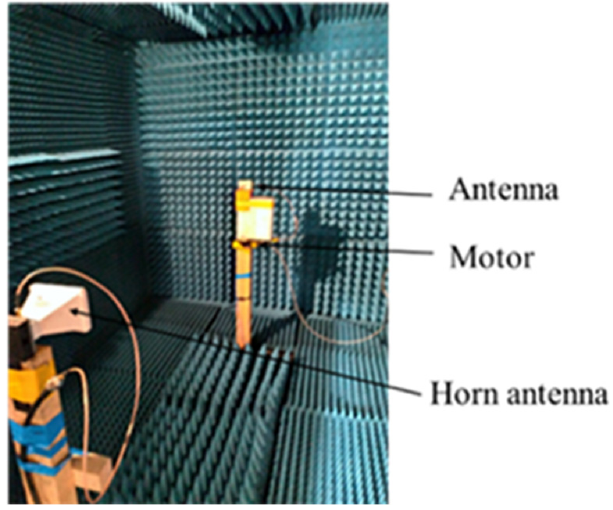
Sensors 2022 , 22 , x FOR PEER REVIEW 9 of 14